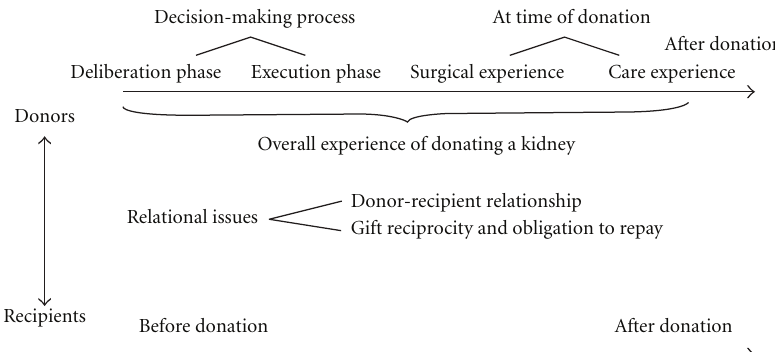
Figure 1: Summary of the major themes of our